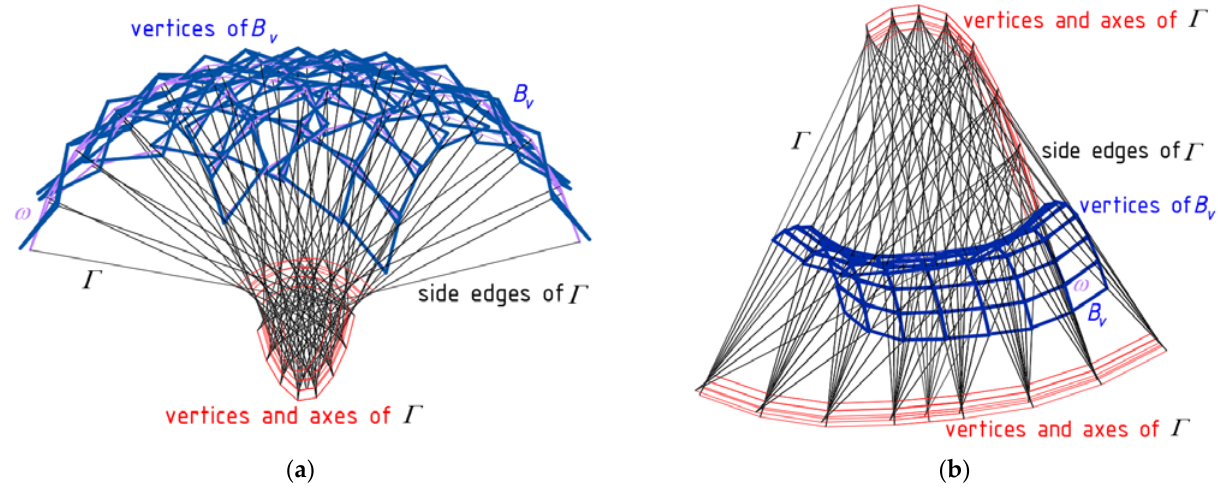
Figure 7. Two complex shell roof structures created on the basis of a polyhedral network Γ , a polygonal network B v and a reference surface ω characterized by: ( a ) the positive Gaussian curvature, ( b ) the negative Gaussian curvature.